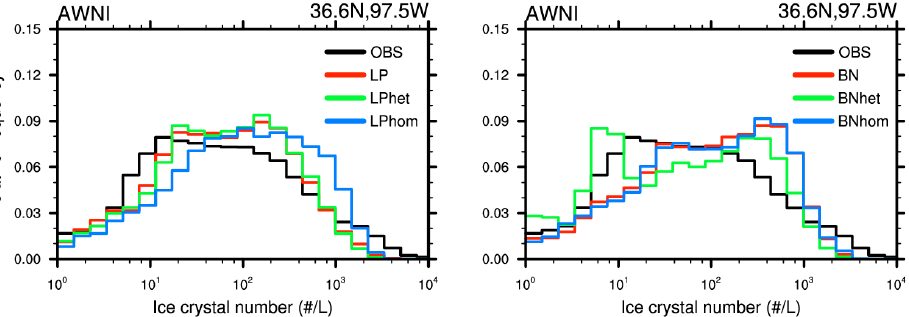
Figure 7. Probability distribution frequency (PDF) of in-cloud ice number concentration (L -1 ). Model results are sampled every 3 hours and interpolated into the field measurement site location (36° 36' N, 97° 29'W). All data are sampled over 7 km.